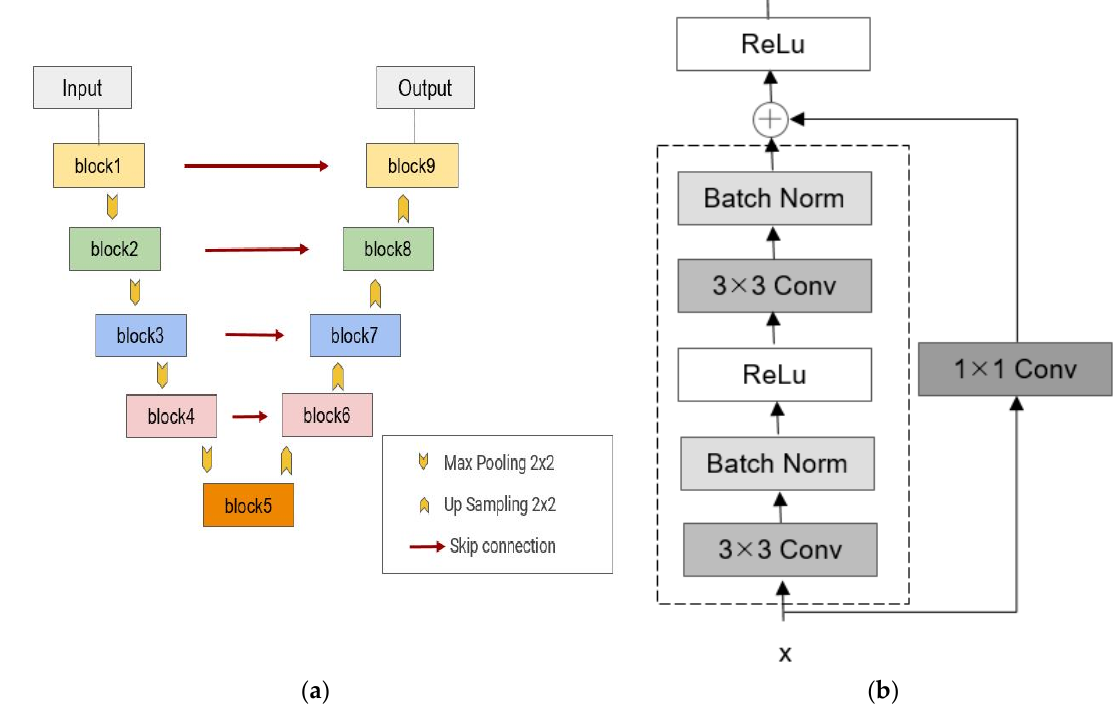
Figure 8. ResU ‐ Net network structure. ( a ) ResU ‐ Net network framework. ( b ) The specific implementation of block. Figure 8. ResU-Net network structure. ( a ) ResU-Net network framework. ( b ) The specific implementation of